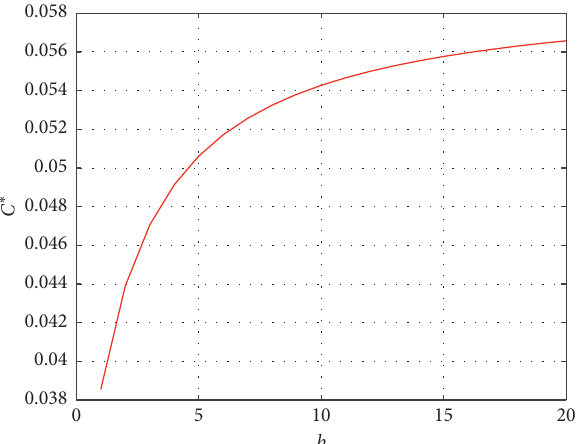
Figure 19: Effect of unit shortage cost b on the optimal inventory cost C ∗ under RMI mode with stochastic demand in the water supply chain.